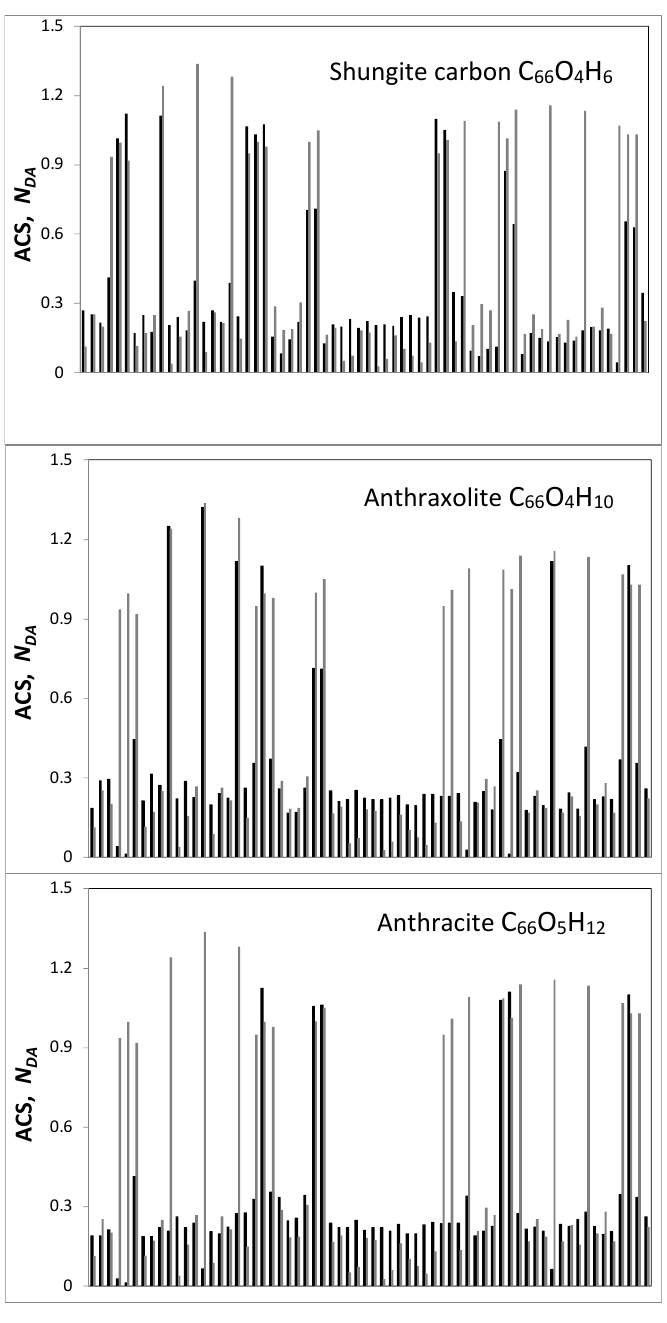
Figure 3. Carbon black C 66 O 4 H 3